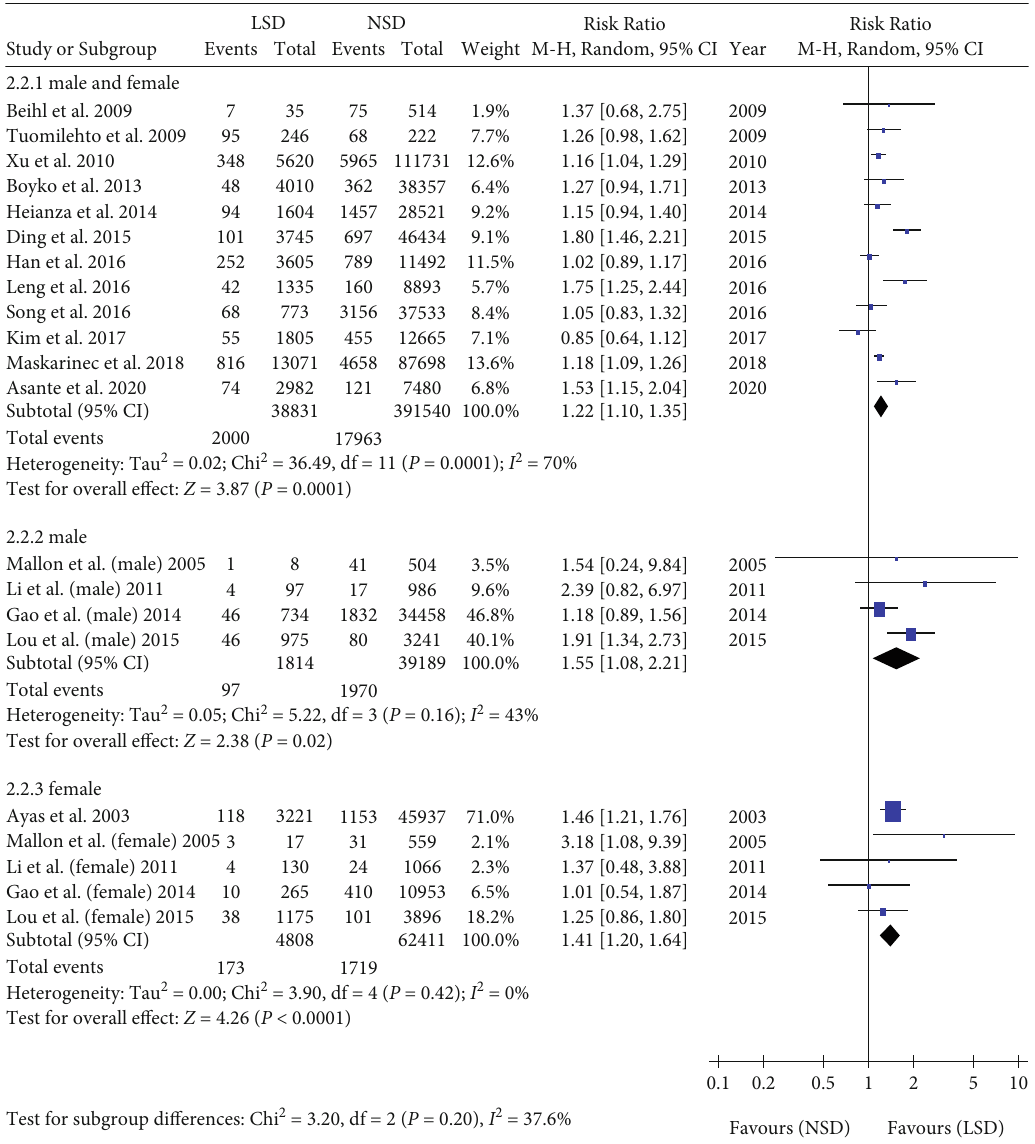
Figure 6: Gender subgroup analysis of the association between LSD and